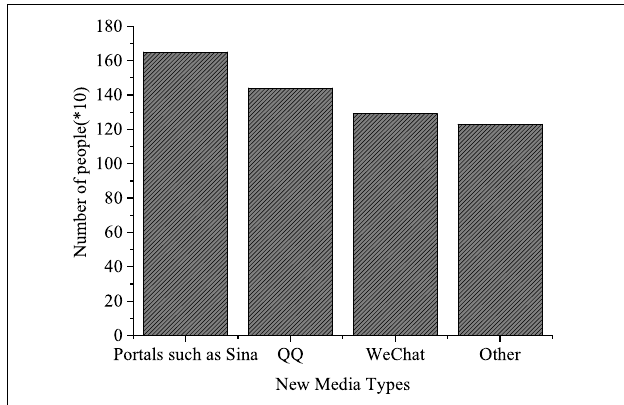
FIGURE 7 | Questionnaire Survey (QS) of the types of new media used.